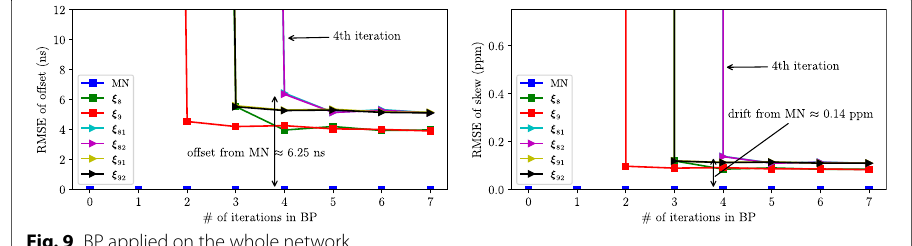
Fig. 9 BP applied on the whole network